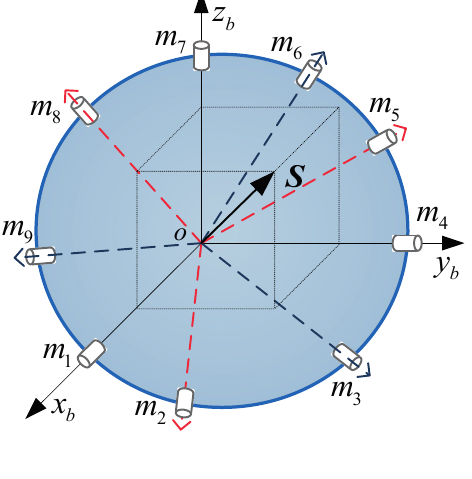
Figure 3. The nine-gyro redundant configuration based on orthogonal rotation